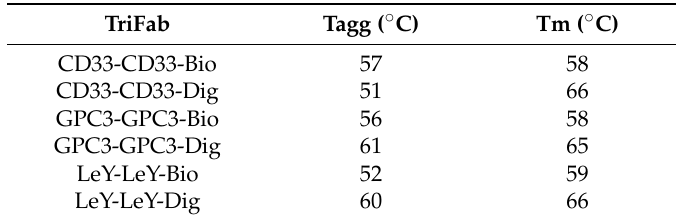
Thermal stability of of TriFabs. Temperature-induced aggregation and unfolding of